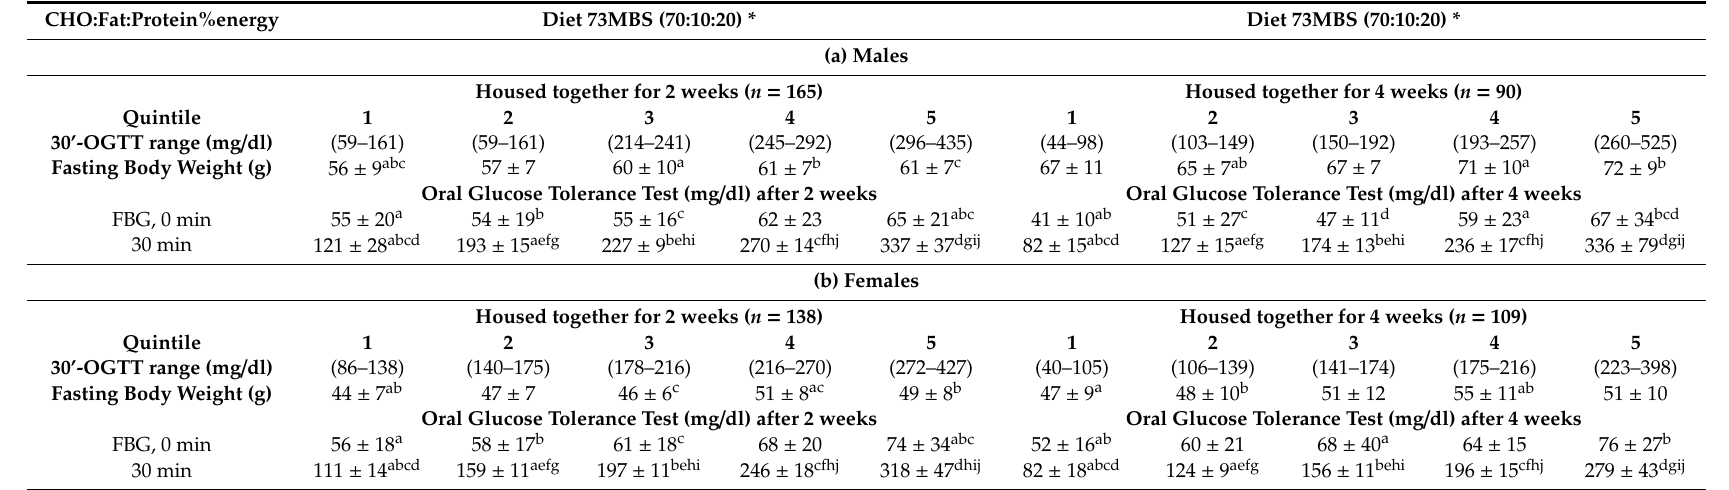
Table 3. (Experiment 1) . ( a ) Quintiles based on the 30’-OGTT for 255 3-week old male Nile rats after being housed with littermates immediately upon weaning for either 2 or 4 weeks and fed a hiCHO diet (Diet 73MBS, NR Study 129); ( b ) Quintiles based on the 30’-OGTT for 247 3-week old female Nile rats after being housed